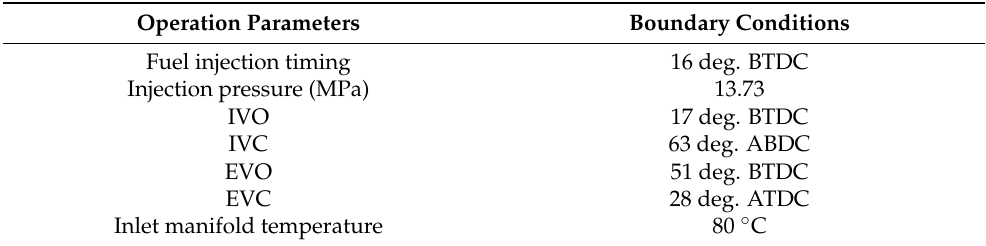
Table 2. Engine operating conditions for model